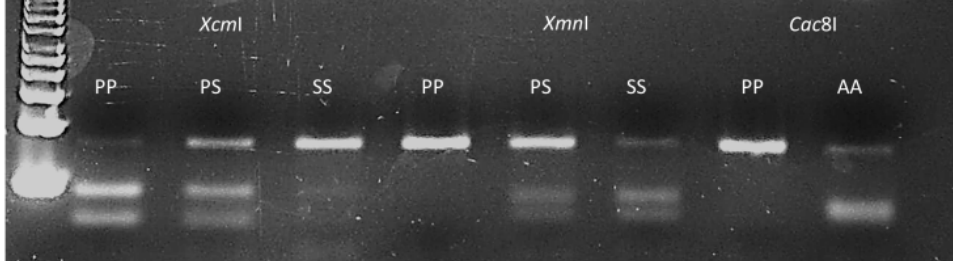
Figure 4. Typical dPACS profiles for wild and P106X mutant EPSPS Eleusine indica individuals. Lane 1: 50 bp DNA ladder, lanes 2, 3 and 4 homozygous wild PP106, heterozygous mutant PS106 and homozygous mutant SS106 individuals respectively as revealed by discriminative enzyme Xcm I; lanes 5, 6 and 7 homozygous wild PP106, heterozygous mutant PS106 and homozygous mutant SS106 individuals respectively as revealed by discriminative enzyme Xmn I; lanes 8 and 9 homozygous wild PP106 and homozygous mutant AA106 individuals respectively as revealed by discriminative enzyme Cac 8I.